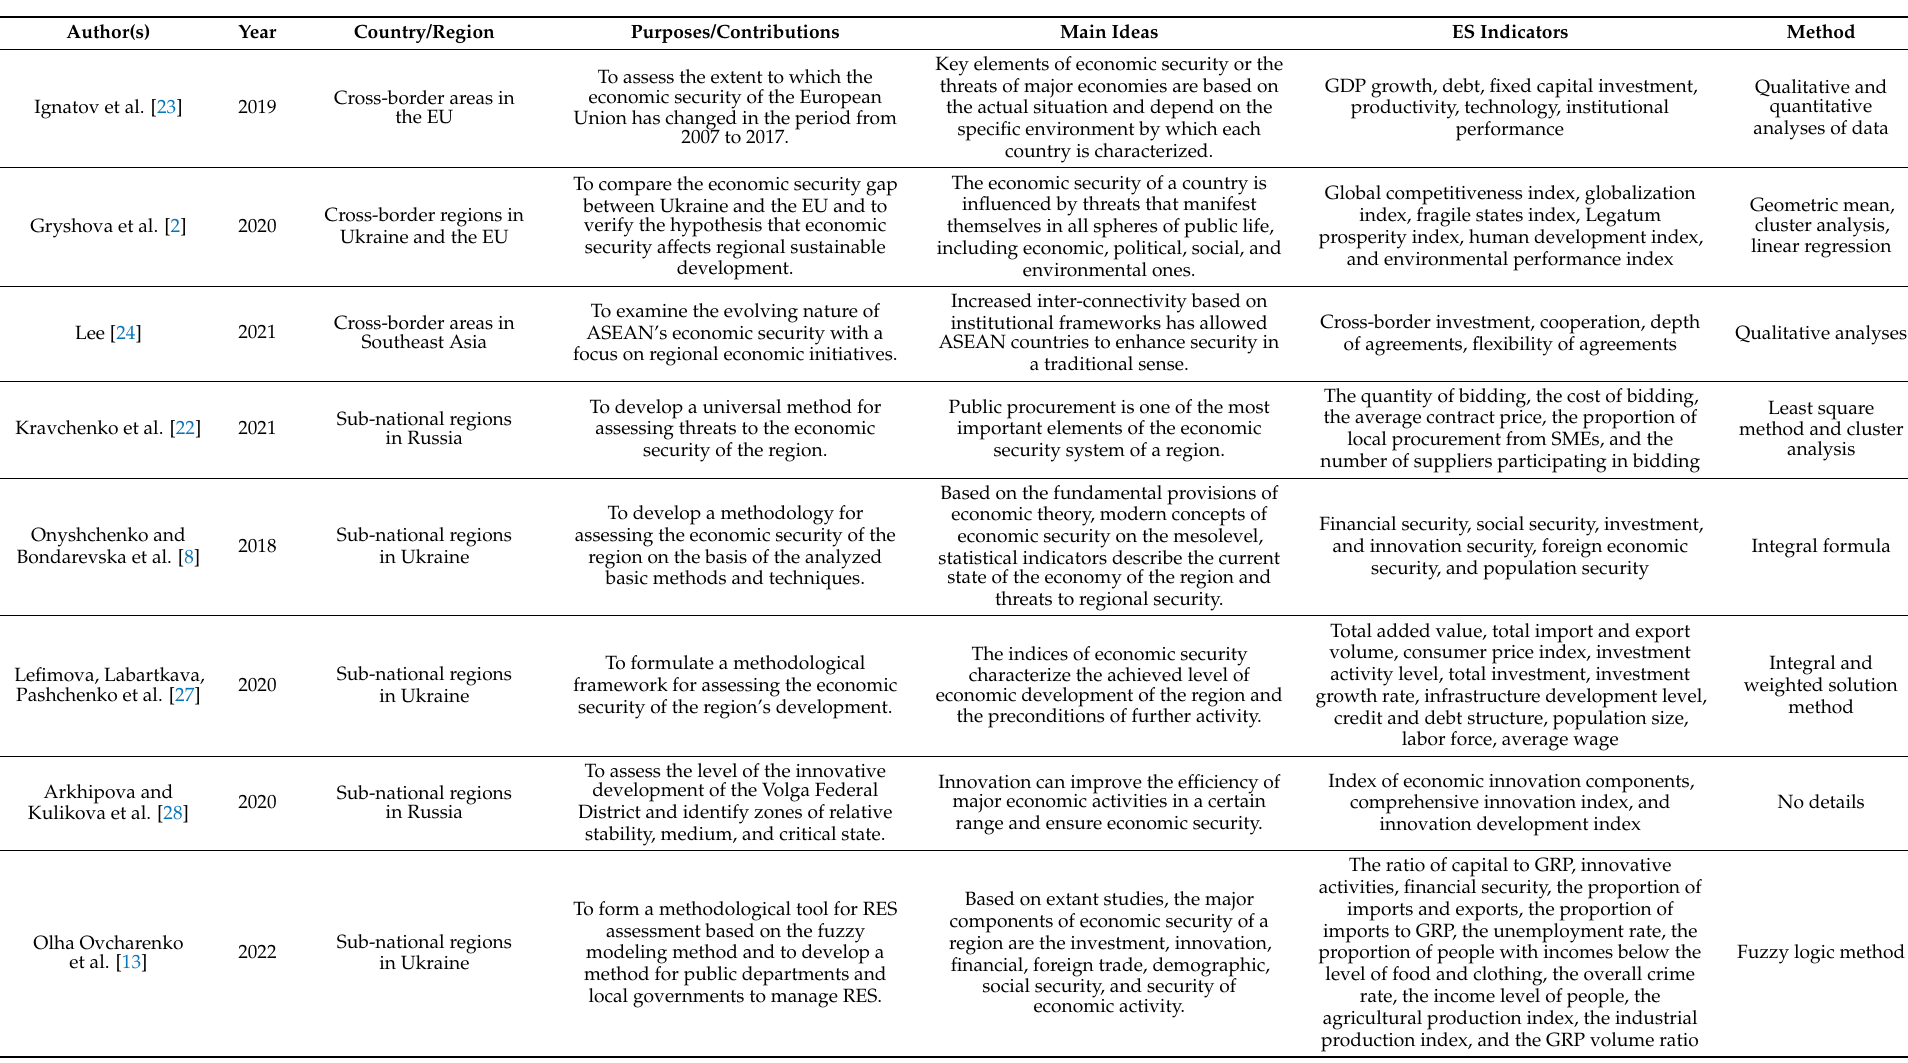
Table 1. Assessment Indicators of Economic Security